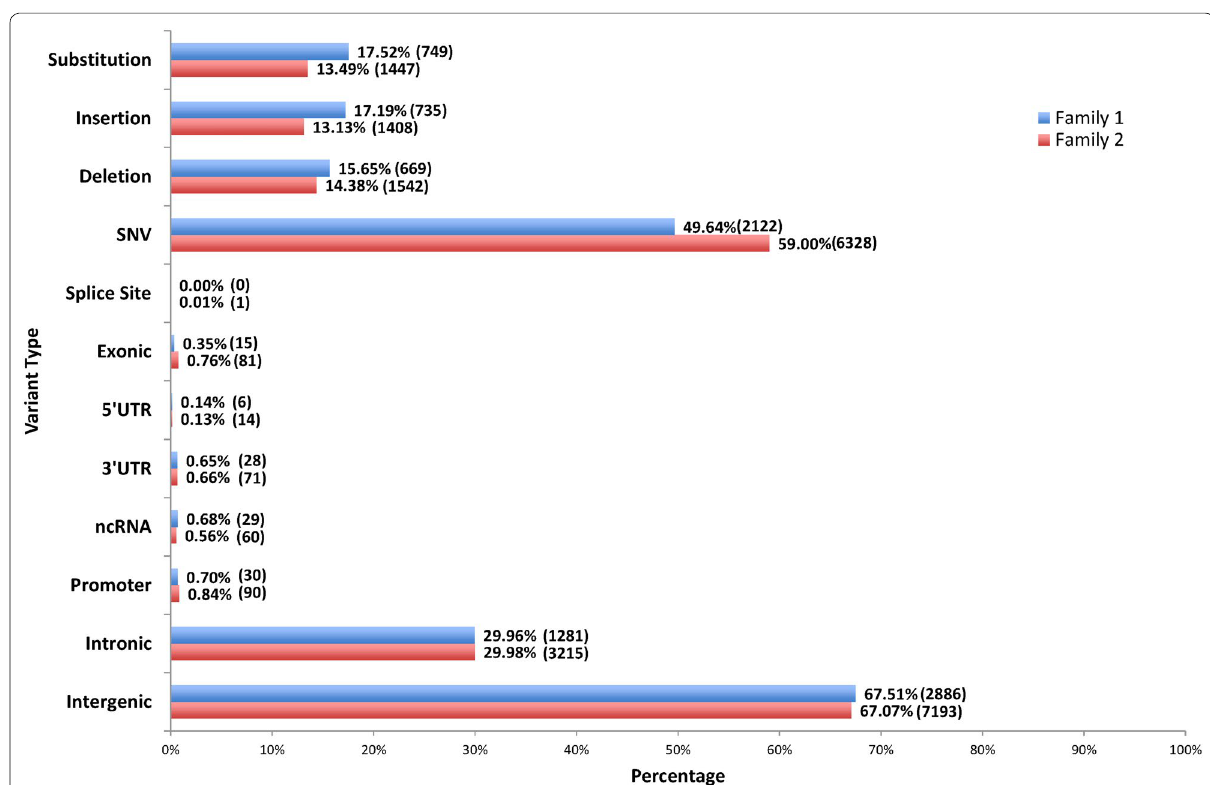
Structural variants fell under five categories: deletions, tandem duplications, distal duplications, inter-chromosomal variations and inversions. There were no inversion differences found between twins in either family. They were not included in subsequent analyses